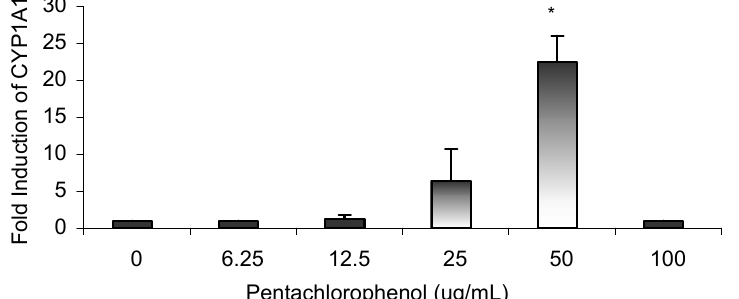
cells exposed to pentachlorophenol : Recombinant Figure 2. Fold induction of CYP1A1 in HepG 2 transfected with CYP1A1 gene promoter fused to the CAT protein were treated with serial HepG 2 dilutions of PCP (0-100 µ g/mL). CYP1A1 induction was based on the expression of CAT-protein using a sandwich ELISA, as indicated in the methodology section. Bars are means + SDs, n=3.